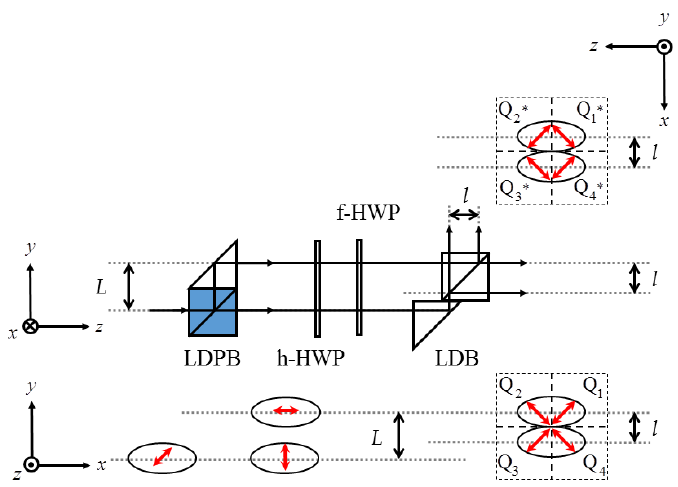
Figure 7. Lateral view of the alignment and assembly considerations of the design (not to scale).